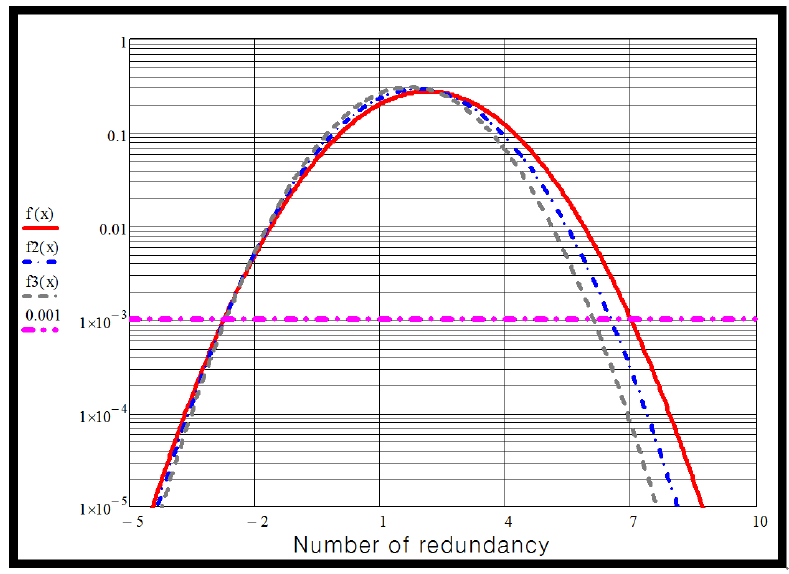
Figure 5. Unavailability function for MMC valve in case of 1-year